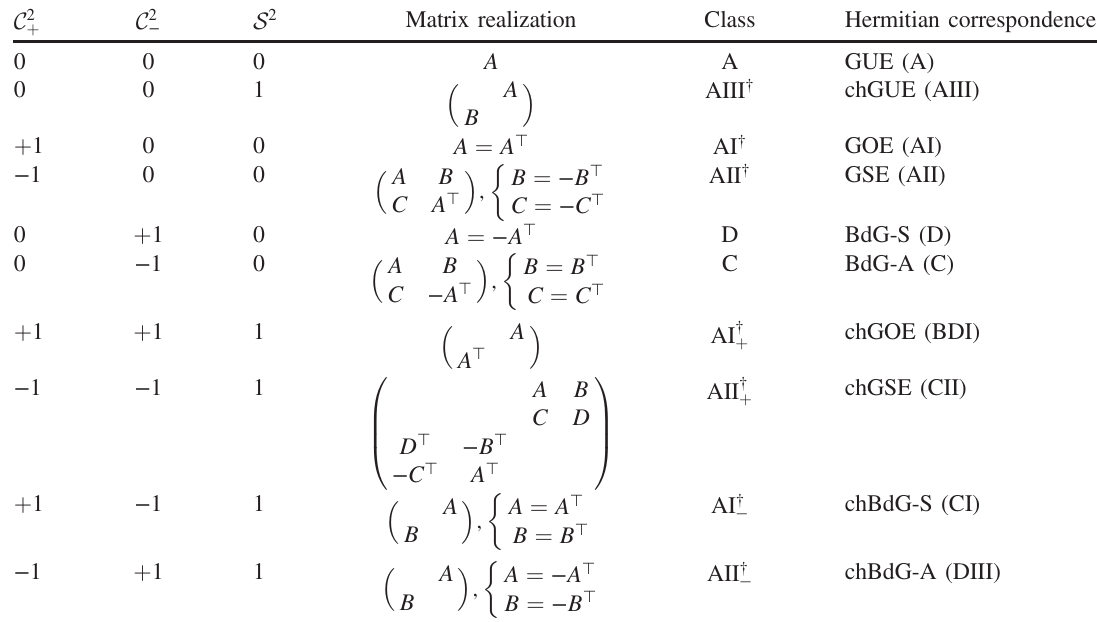
TABLE I. Non-Hermitian symmetry classes without reality conditions, nine of which are realized in the non- Hermitian SYK model (i.e., all except class AIII † ). For each class, we list its antiunitary and chiral symmetries, an explicit matrix realization [92], its name under the Kawabata-Shiozaki-Ueda-Sato classification [66], and the corresponding Hermitian ensemble. In the matrix realizations, A , B , C , and D are arbitrary non-Hermitian matrices unless specified otherwise, and empty entries correspond to zeros. In the last column, we list the AZ classes [8] that are in one-to-one correspondence with the non-Hermitian classes without reality